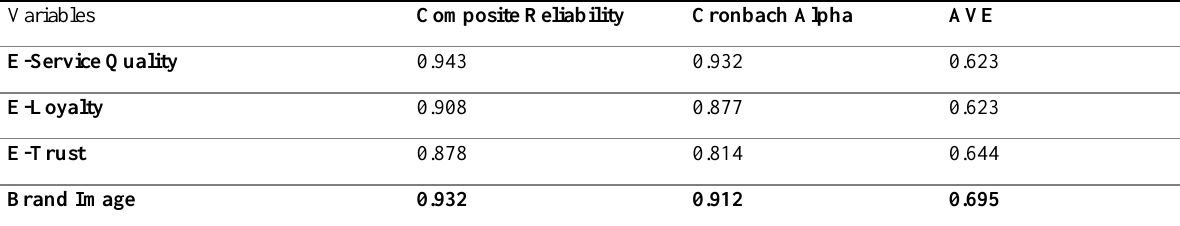
Table 1: Composite Reliability, Cronbach Alpha, AVE